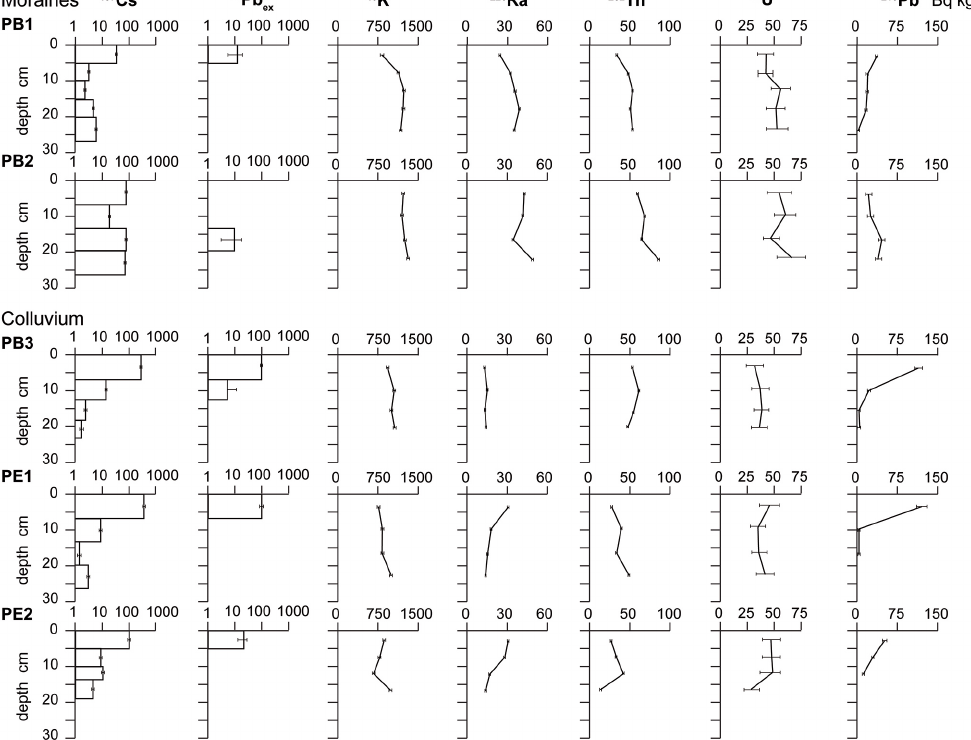
Solid Earth, 5, 485–498, 2014